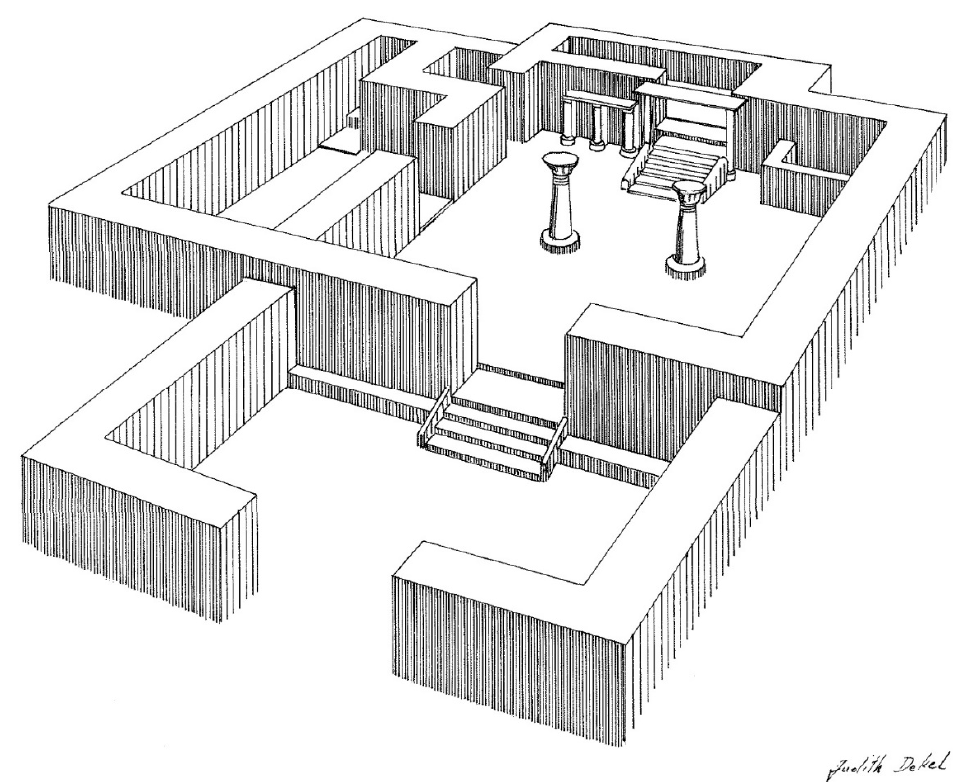
Figure 4. Suggested reconstruction of the main Acropolis Temple Complex at Lachish (From Ussishkin 2004: Figure 6:4; courtesy of the Institute of Archaeology of Tel Aviv University).